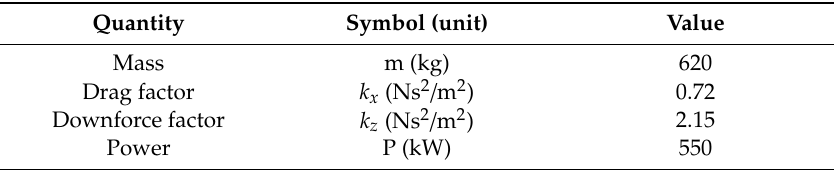
Table 1. Main vehicle